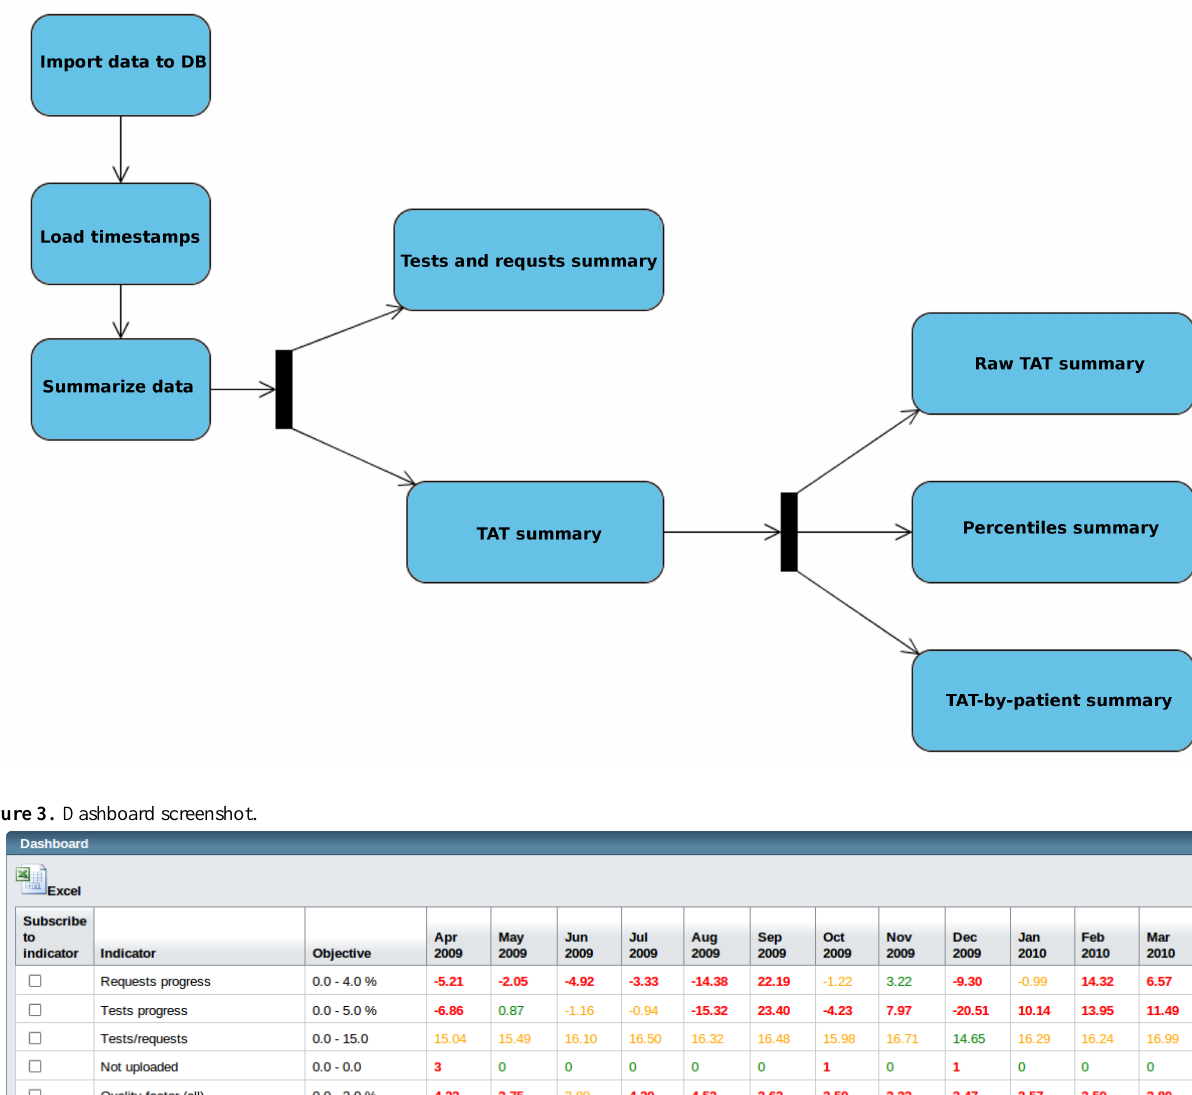
Figure 2. Data loading and summarizing outline.